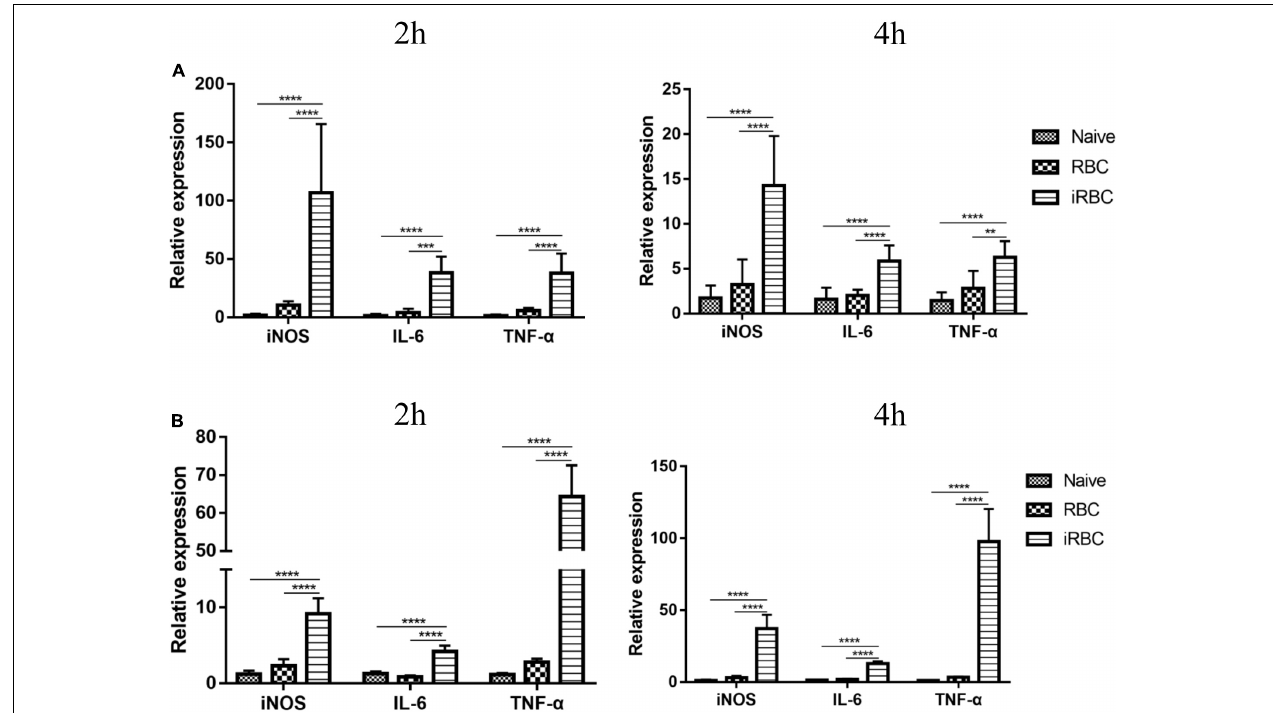
FIGURE 6 | Effects of B. microti on macrophage polarization. (A) qPCR analysis of the effects of B. microti on the expression levels of iNOS, IL-6, and TNF- α in peritoneal macrophages; mice were intraperitoneally injected with B. microti , followed by collecting peritoneal macrophages separately at 2 and 4 h post-injection. (B) qPCR analysis of the effects of B. microti on the expression levels of iNOS, IL-6, and TNF- α in RAW264.7 macrophage cells; B. microti -infected RBCs were incubated with RAW264.7 cells for 2 and 4 h, respectively. Error bars are SD; ** p ≤ 0.0021, *** p ≤ 0.0002, **** p ≤ 0.0001.